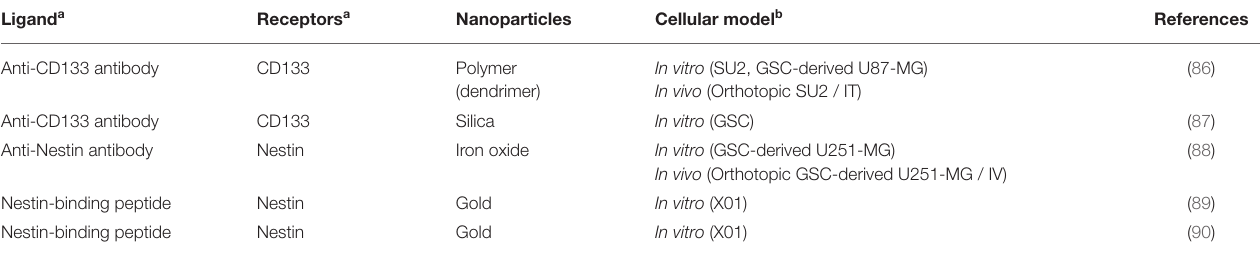
TABLE 2 | Selection of ligands for GBM cancer stem cell targeting, with the corresponding receptors.